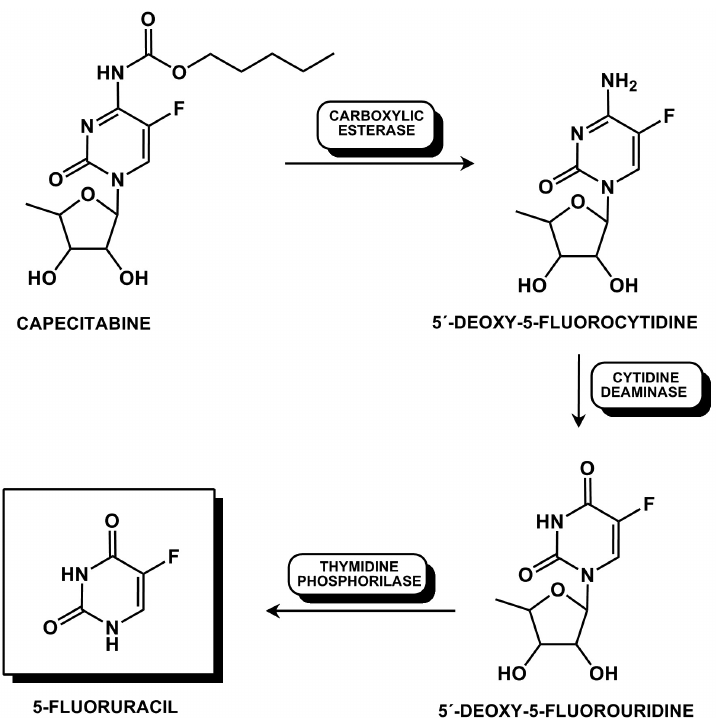
FIGURE 30 - Diagram of the metabolic bioactivation of capecitabine.